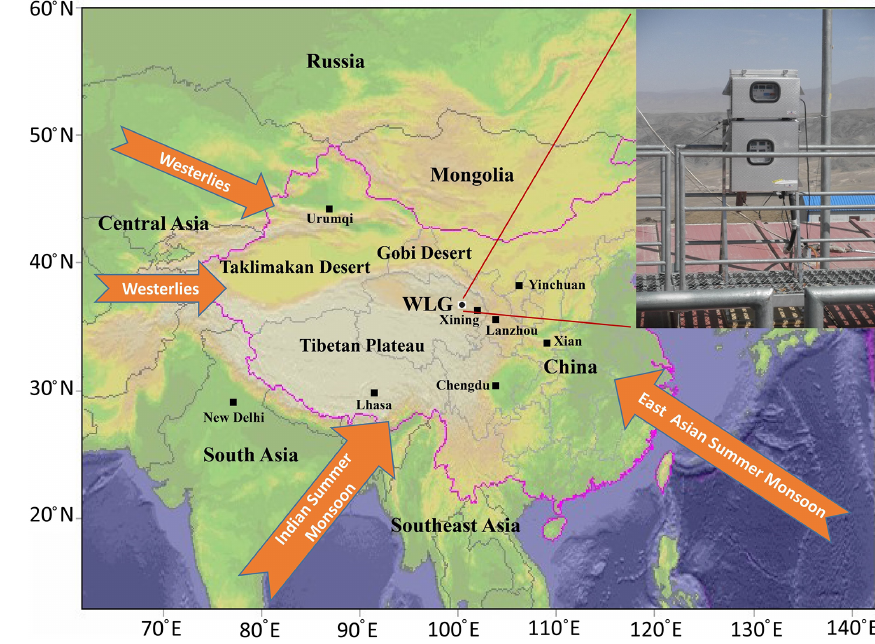
Figure 1. Map showing the location of WLG and distribution of the deserts and cities around WLG.